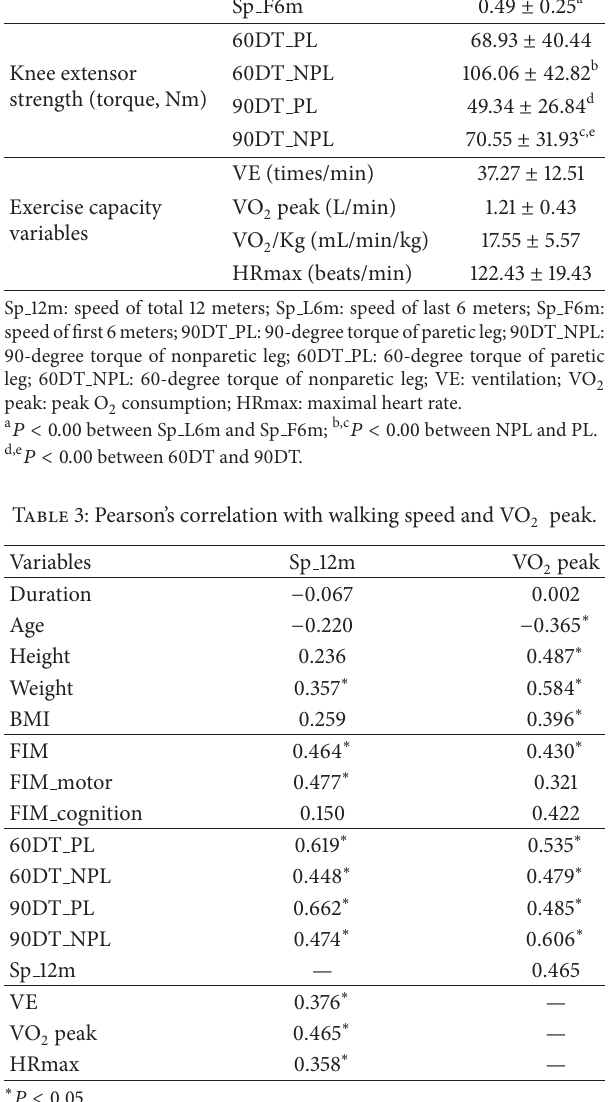
Table 2: Walking speed, peak torque of knee extensors, and exercise tolerance test results.